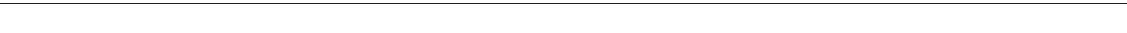
Fig. 1 myo1d is required for Kupffer ’ s vesicle morphogenesis. a myo1d is ubiquitously expression. White arrow demarcates the region where KV is formed. b TALEN mediated genome editing of myo1d . TALENs were designed to target myo1d exon 2 (red arrow) encoding the myosin motor domain (blue). Calmodulin binding IQ motif (green) and Tail Homology 1 (TH1, red) domains are also indicated. Three F1 alleles were isolated, pt31a-c , with predicted amino acid sequence indicated. c – e myo1d MZ mutants showed KV lumen formation defects. Representative DIC images showing KV of myo1d MZ mutants were either smaller and dysmorphic lumens ( c ). ZO-1 staining at 8S con fi rmed that the apical surface of KVs were smaller or dysmorphic in myo1d mutants when compared to controls. myo1d MZ;Tg(dusp6:GFP-MA) injected with H2BmCherry mRNA showing dysmorphic KV epithelial cell morphology and decreased lumen area, when compared to controls. Lumen marked by dotted circular lines were quanti fi ed for area (WT: n = 44, myo1d MZ : n = 46) ( d ) and circularity (WT: n = 20, myo1d MZ : n = 21) ( e ). f – h Dysmorphic otic vesicle (OV) observed in myo1d MZ embryos. Tg(dusp6:GFP-MA) and myo1d MZ; Tg(dusp6:GFP-MA) embryos ( f ) or stained with aPKC (green) and acetylated tubulin (red) ( g ) at 24 hpf show smaller OVs and quanti fi ed (WT: n = 8, myo1d MZ : n = 12) ( h ). KV lumen was considered small when it was below threshold lumen size (1000 µ m 2 ). Unpaired t test was used with , *** p < 0.001, **** p < 0.0001 indicated. Data shown in the graphs are mean ± SEM. Scale bar, 50 µ